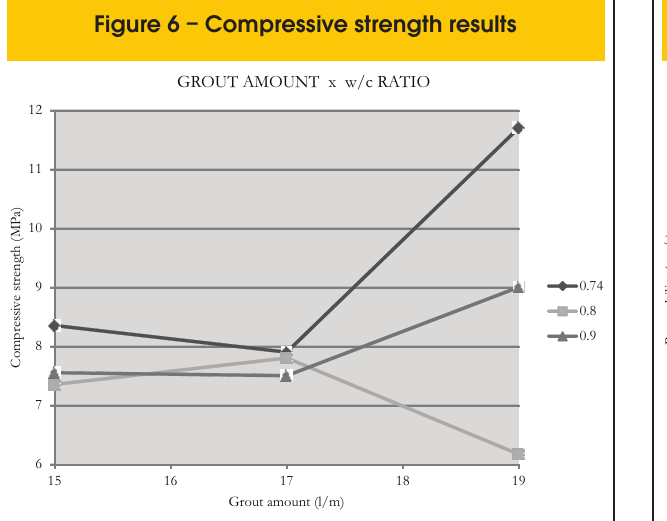
Figure 6 – Compressive strength results